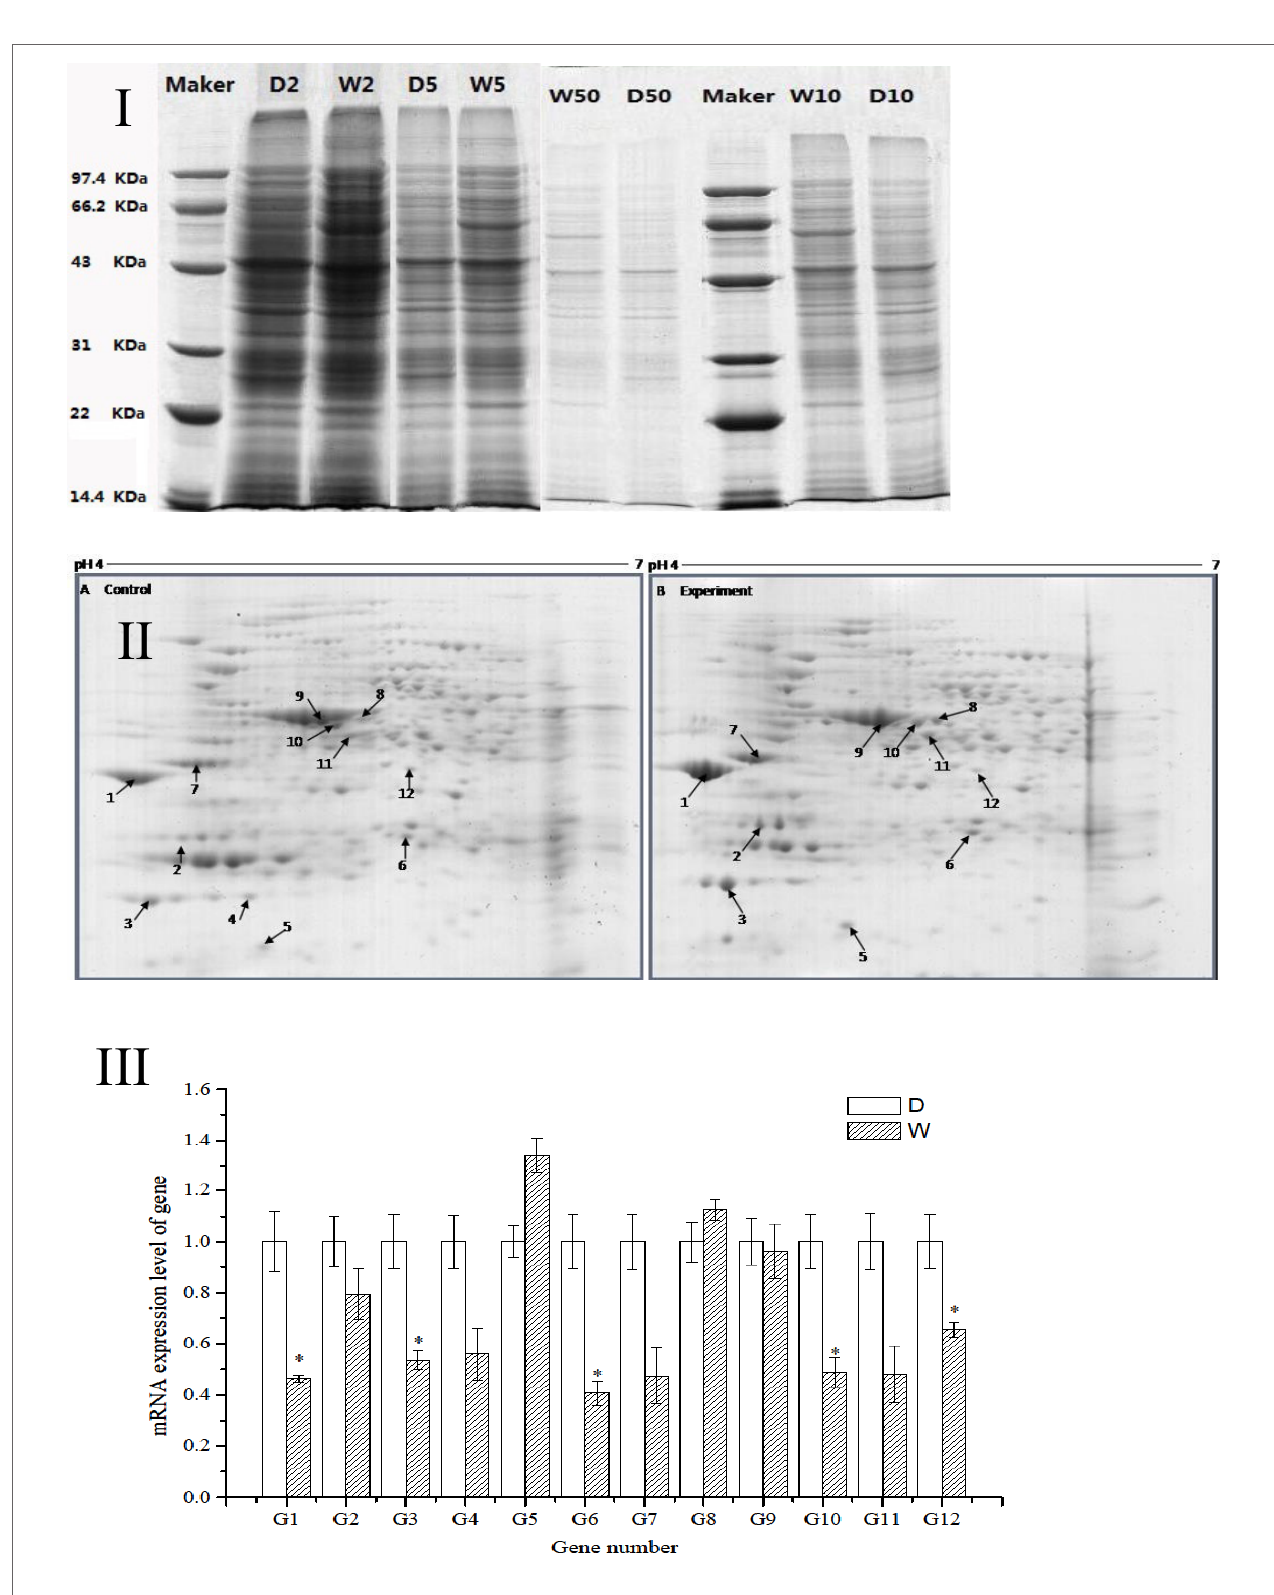
FigUre 2 | (i) SDS-PAGE electropherogram. D, fresh water; W, sewage. (ii) The 2D-PAGE protein map of S. putrefaciens under the two different environment. A, Fresh water; B, sewage. Arrows and spot numbers refer to differentially expressed proteins. (iii) The RT-qPCR of differential expression gene of S. putrefaciens . D, fresh water; W,